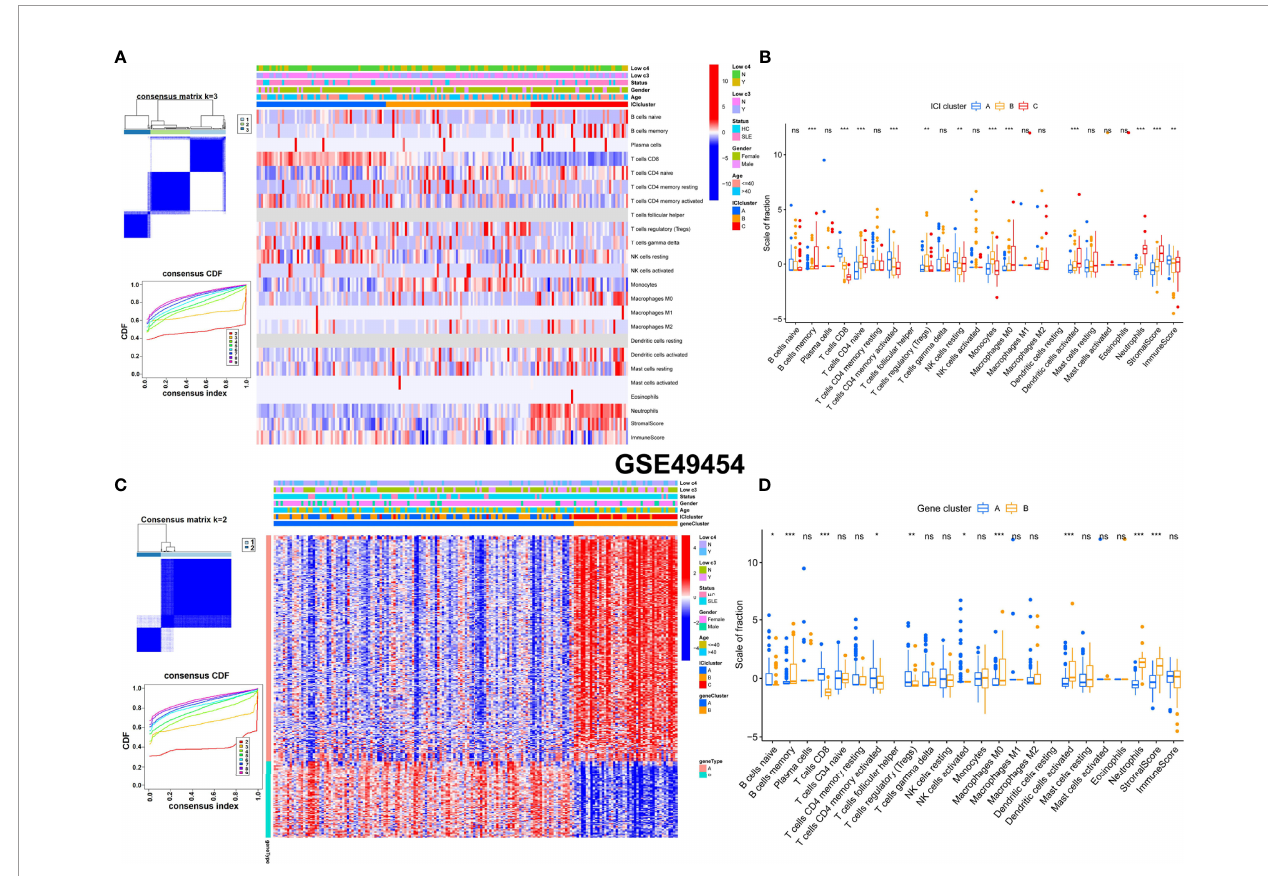
FIGURE 8 | Construction of gene clusters and ICI clusters and comparison of the differences in immune cells in GSE49454. (A) The optimal cluster number was k = 3, CDF curves (k = 2 – 9). Heatmap of the expression patterns of genes (red: high expression; blue: low expression). The upper columns consist of age, sex, low c3, low c4, and ICI clusters of SLE. (B) Fractions of in fi ltrated immune cells in three ICI clusters in the GSE49454 cohort. (C) The consensus clustering number was k =2. CDF curves (k = 2 – 9). A heatmap of the expression patterns of genes is shown. The upper columns consist of age, sex, low c3, low c4, ICI clusters, and gene clusters of SLE. (D) Fractions of in fi ltrated immune cells in two gene clusters of the GSE49454 cohort. *p < 0.05; **p < 0.01; ***p < 0.001; ns, not signi fi